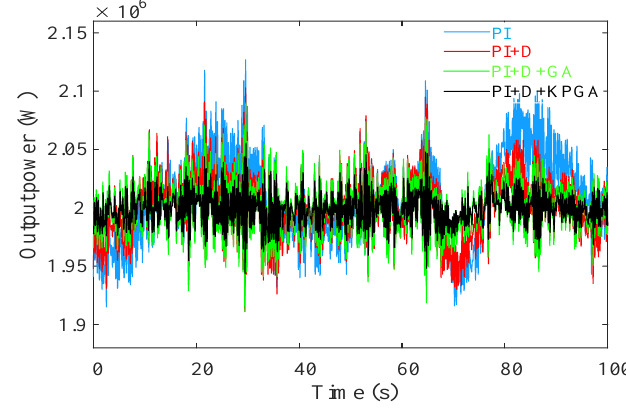
Figure 14. Change curve of output power.